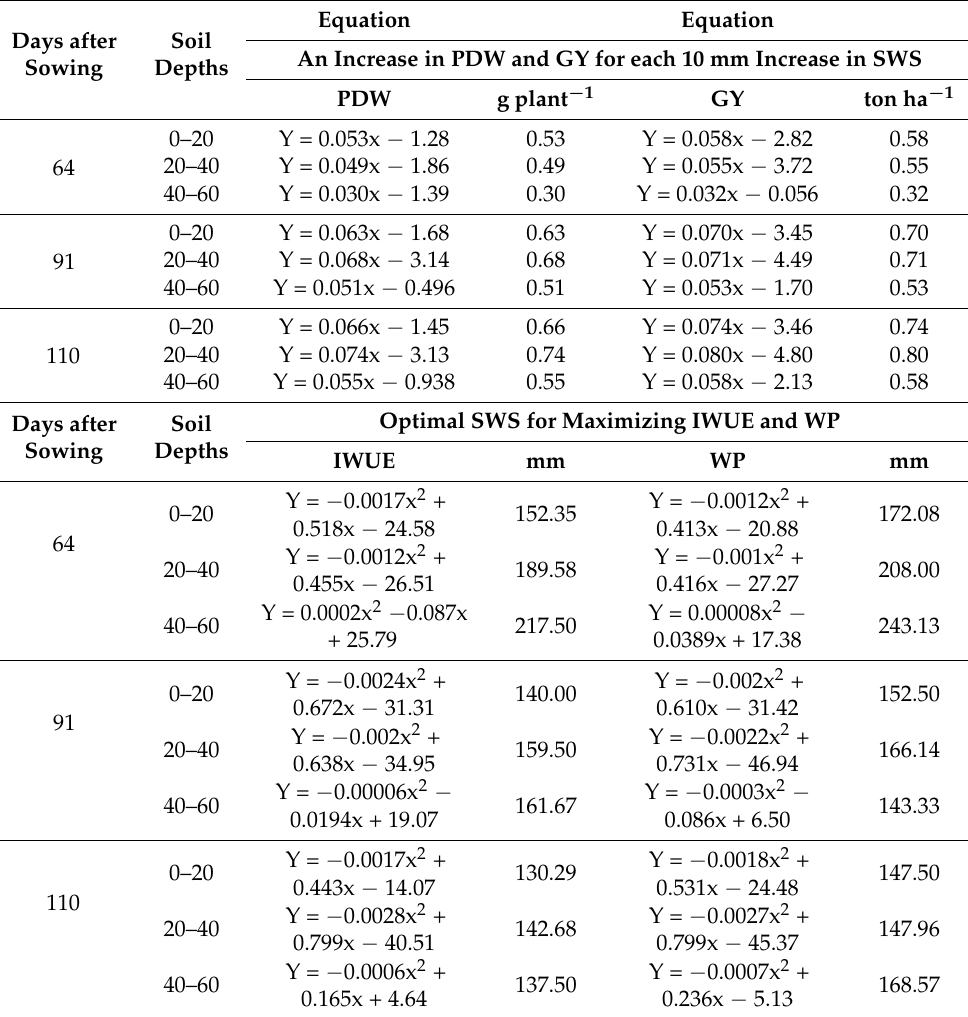
Table 5. Functional relationship between plant dry weigh (PDW), grain yield (GY), irrigation water use efficiency (IWUE), and water productivity (WP) (Y) and total soil water storage before irrigation (x) at different soil depths and measured time